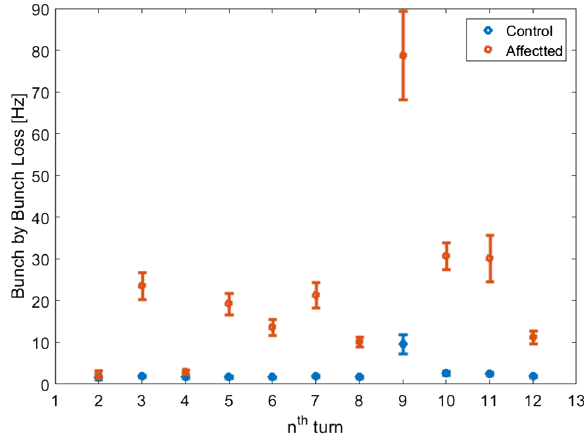
FIG. 13. Beam loss rate at the collimator vs n, where the hollow lens is turned on every nth